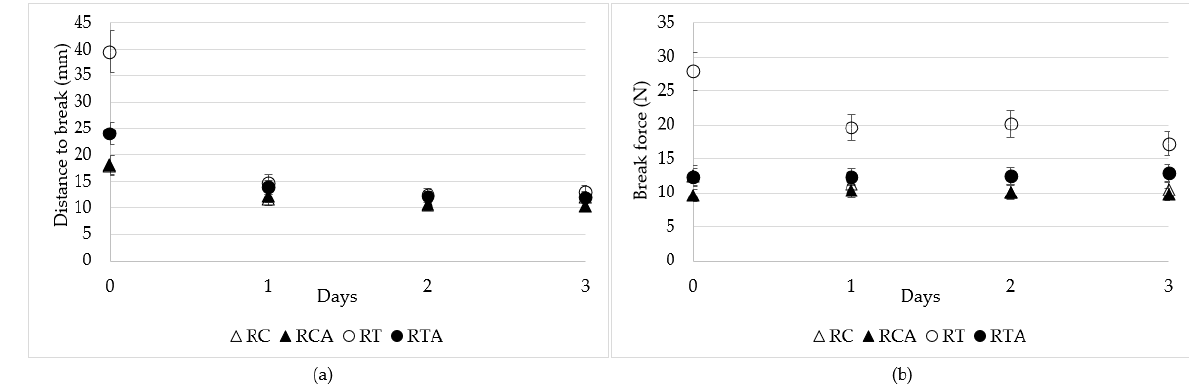
Figure 3. Parameters of “Tortilla test”: ( a ) break distance and ( b ) break force in FB samples over a storage period of three days.